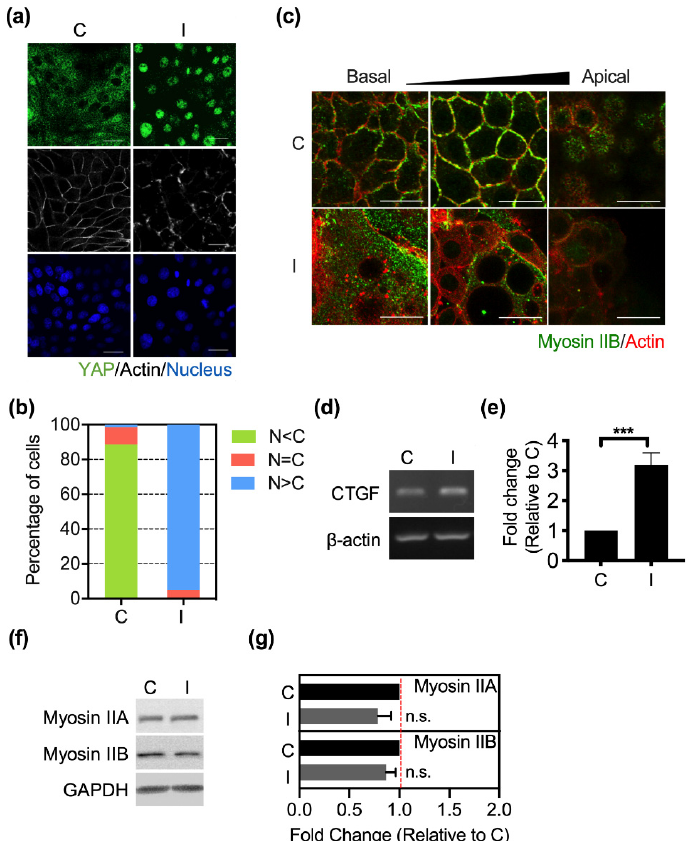
Figure 1. Ha-Ras V12 disrupted the cell junction integrity and induced YAP nuclear translocation at the overconfluent stage: ( a ) MK4 cells at the overconfluent stage were treated with (I) or without (C) IPTG (5 mM) for 24 h. Representative confocal images of cells, which were stained with YAP (green), Hoechst 33,258 (blue), and Phalloidin 647 (gray). Scale bar = 20 µm; ( b ) Percentage of cells with predominant nuclear YAP localization (N > C), equal nuclear and cytosol YAP localization (N = C), and predominant cytosol YAP localization (N < C); ( c ) MK4 cells were treated with or without IPTG (5 mM) for 24 h. Representative confocal images of cells, which were stained with myosin IIB (green) and Phalloidin (red). The arrow indicates the different z sections of cells from the basal to the apical level. Scale bar = 20 µm; ( d , e ) Representative PCR and quantification results of the YAP downstream gene expression of CTGF; ( f,g ) Representative immunoblots and quantification results of tensional proteins, including myosin IIA and myosin IIB. All data are expressed as the mean ± SEM from three independent experiments. n.s.: Not significant, *** p <